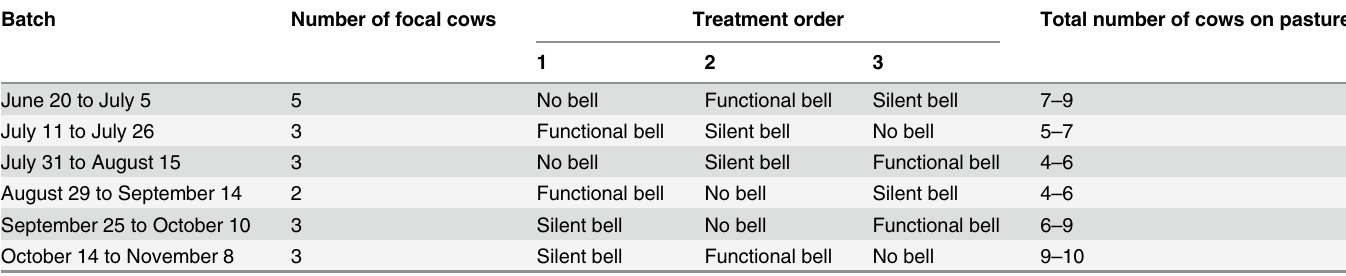
Table 1. Experimental